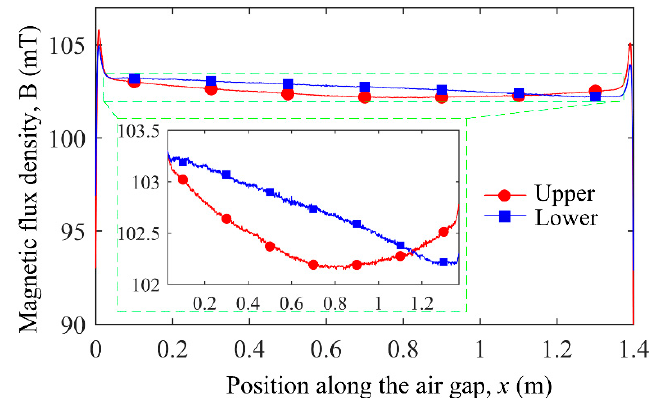
Figure 13. Measurement results of MFD along the upper and lower air gaps. Reproduced with permission from [19], IEEE, 2019.